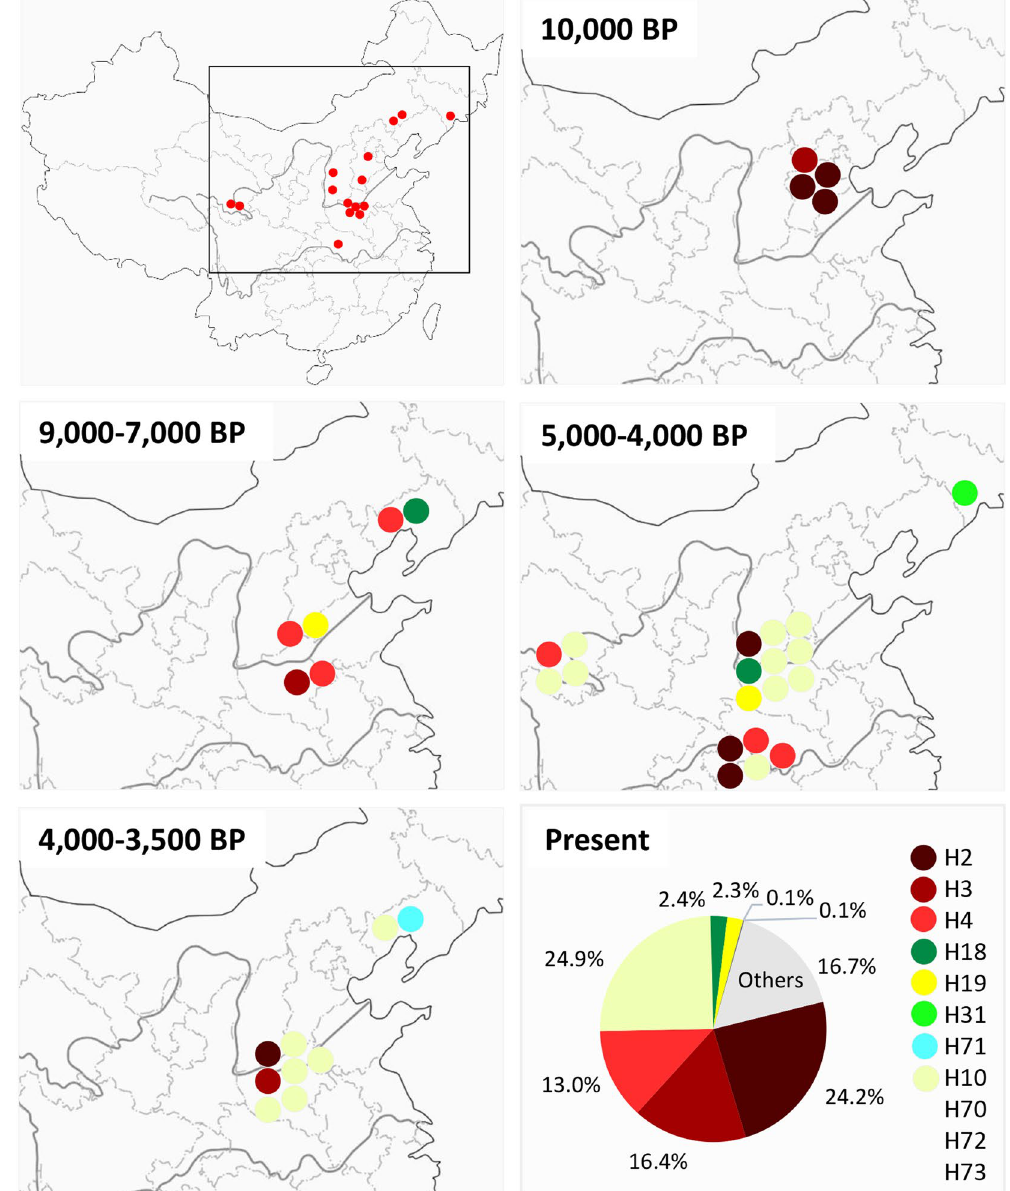
Figure 4. Temporal transition of mtDNA control region haplotypes of ancient Chinese pigs in different regions. The upper left map shows the location of the investigated region within China. From left to right and top to bottom: Time series of maps identifying the locations and haplotypes of ancient pig samples from which DNA sequences were obtained. Each symbol corresponds to a single sample. Different colours indicate different haplotypes (see lower right panel of the figure). The pie chart at the lower right shows the proportions of the different haplotypes in present day Chinese pigs. Maps are modified from free map materials deposited in the public database of National Administration of Surveying, Mapping and Geoinformation